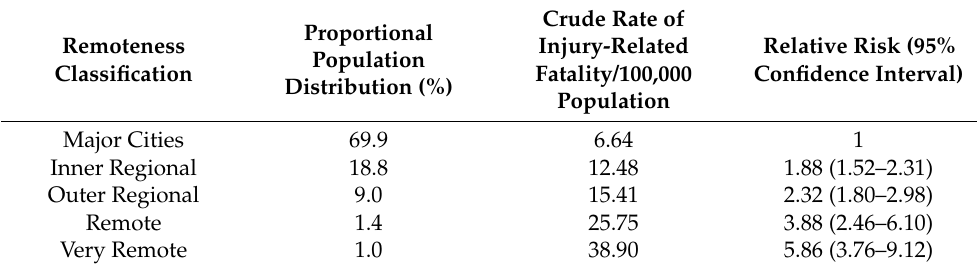
Table 3. Crude rate of injury-related fatality by remoteness classification, relative risk with